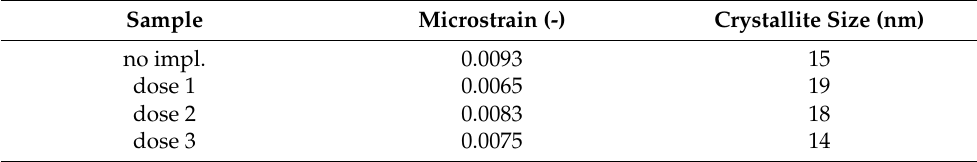
Table 1. The results of calculation for (111) using fitting to pseudo-Voigt function.